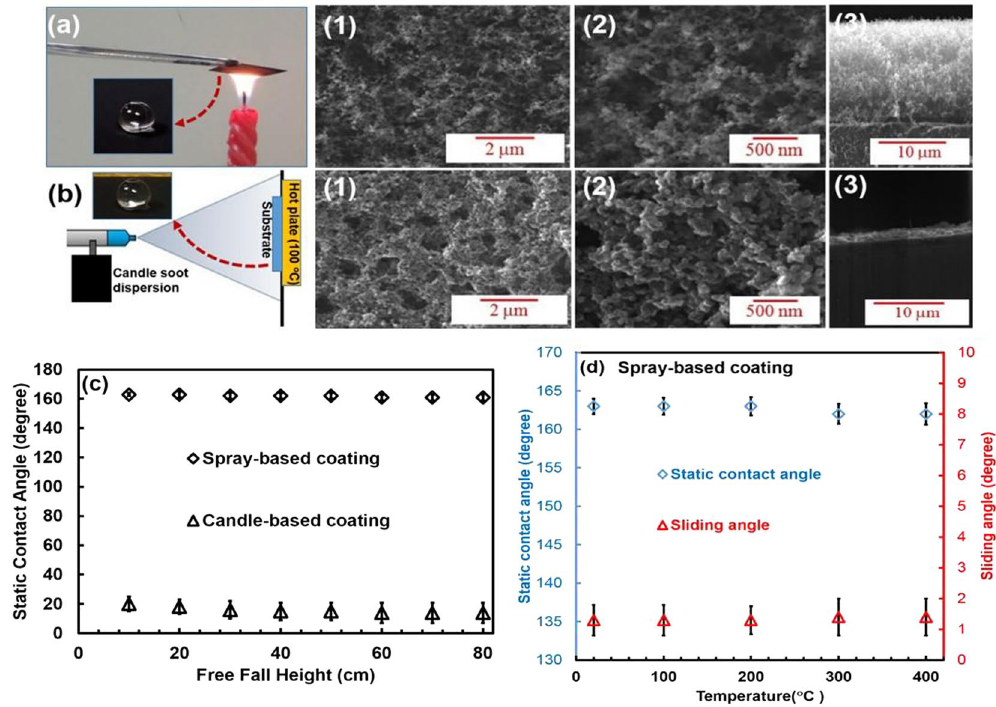
Figure 3. Fabrication of superhydrophobic surfaces using candle soot dispersions. ( a ) Direct candle flame soot deposition. (a-1 and 2) FESEM images of the surfaces prepared by direct candle flame soot deposition with different magnifications, (a-3) Cross sectional view of the surfaces prepared by direct candle flame soot deposition. ( b ) Spray coating method. (b-1 and 2) FESEM images of spray based coatings with